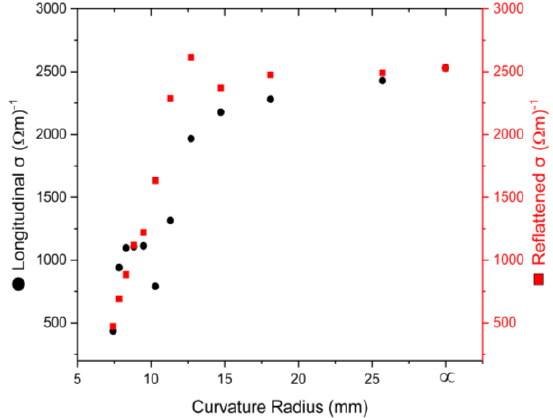
Figure 5. Behaviour of longitudinal and re-flattened conductivity with radius for positive bending measured at room temperature (20 °C). The longitudinal conductivity shows a decreasing trend reaching a minimum of ~1315 (Ωm) −1 at the critical radius of 11.3 mm, which is corroborated by the abrupt fall of the re-flattened conductivity for smaller radius.